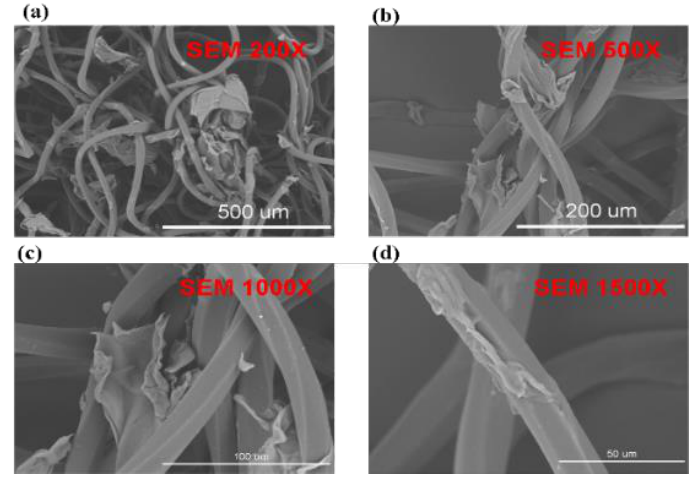
Figure 2. SEM images of the NT samples at magnifications of ( a ) 200×, ( b ) 500×, ( c ) 1000×, and ( d ) 1500×.